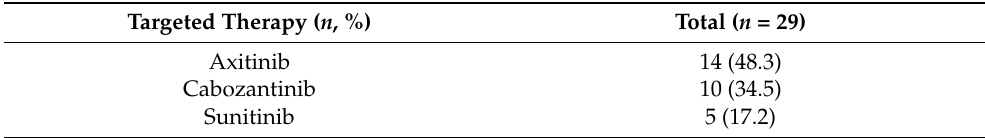
Table 2. First molecular-targeted therapy in patients who discontinued nivolumab plus ipilimumab combination therapy.